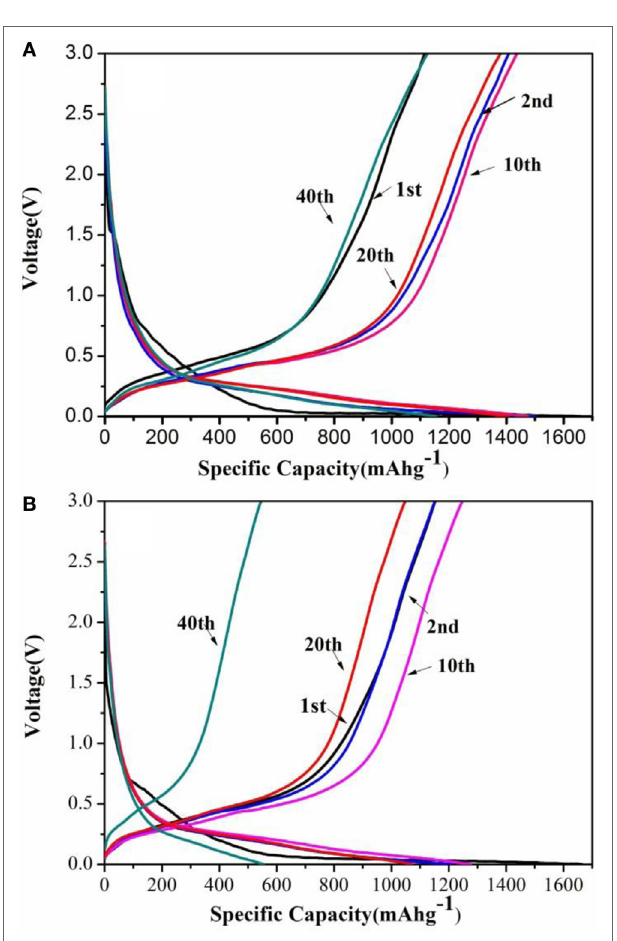
FigUre 6 | Cycling performance of Si, SG1, SG2, and SG3 anodes at 0.2 A g − 1